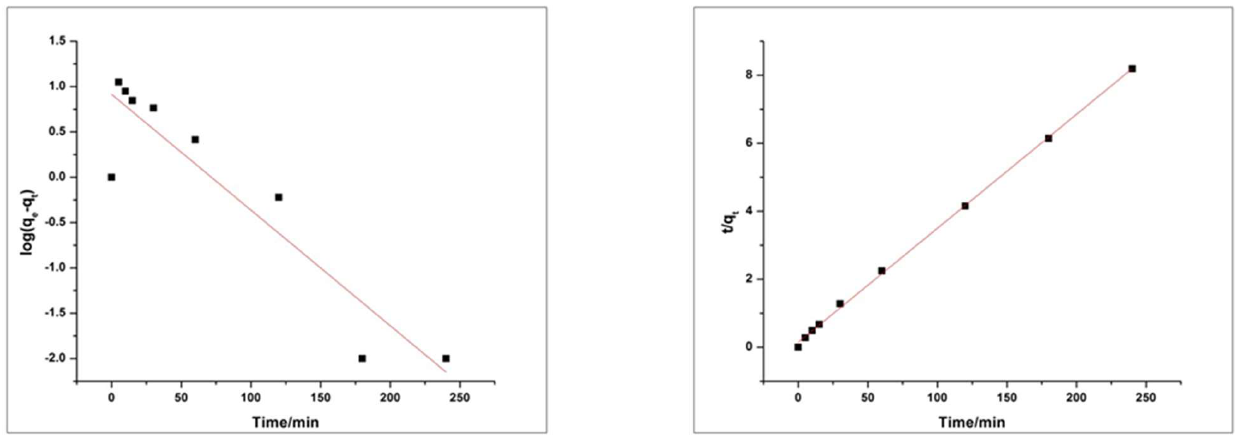
Figure 21. Pseudo first order ( left ) and Pseudo second order ( right ) kinetic plot for RhB.